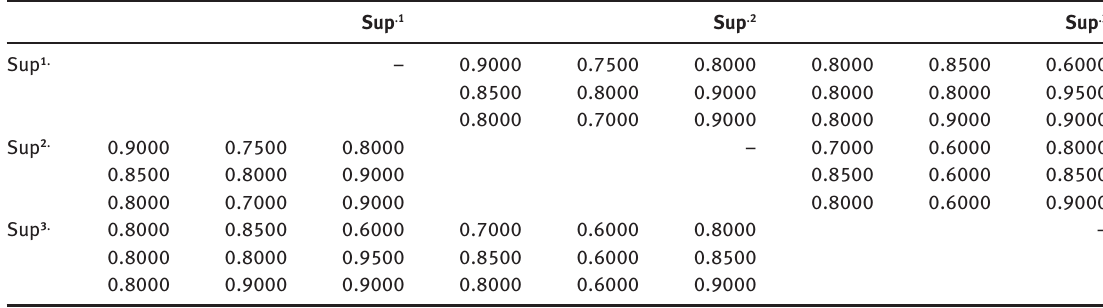
Table 4: Supports Between R ( k ) and R ( t ) .